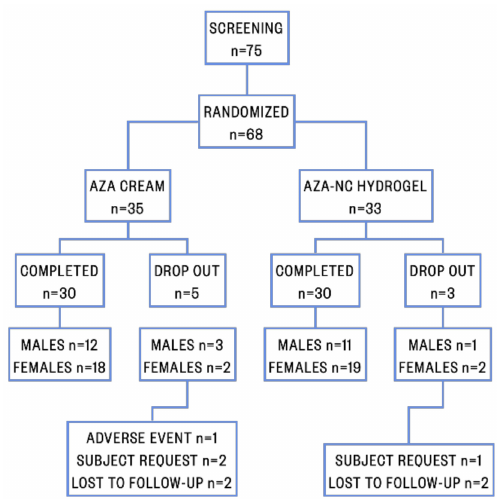
Figure 2. Patient flow diagram.